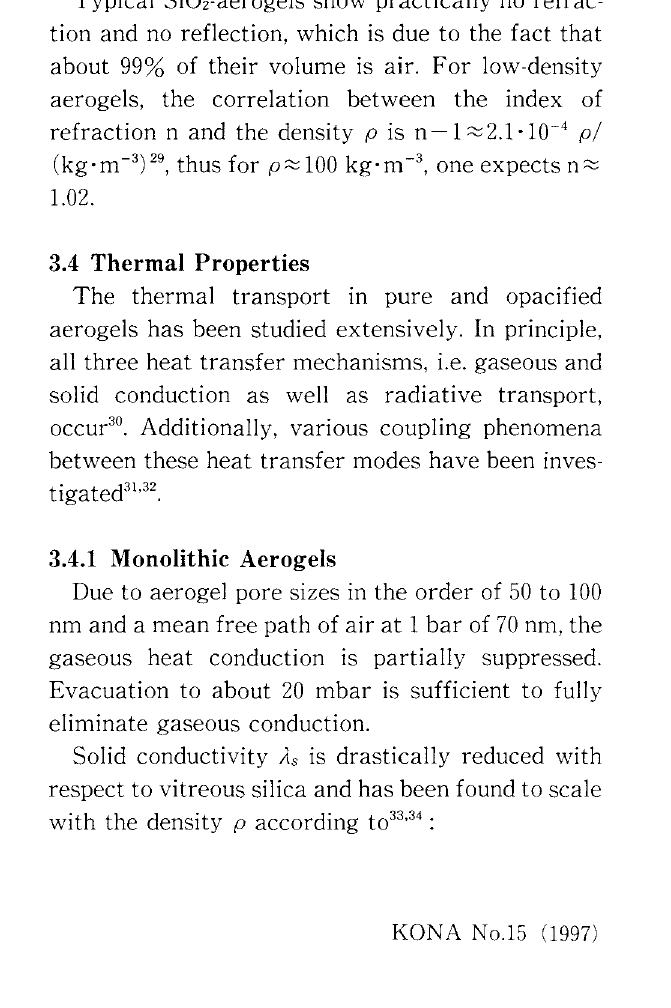
Fig. 5 SAXS patterns of three differently catalyzed aerogels of the same apparent density compared to the SAXS pattern of fumed silica.